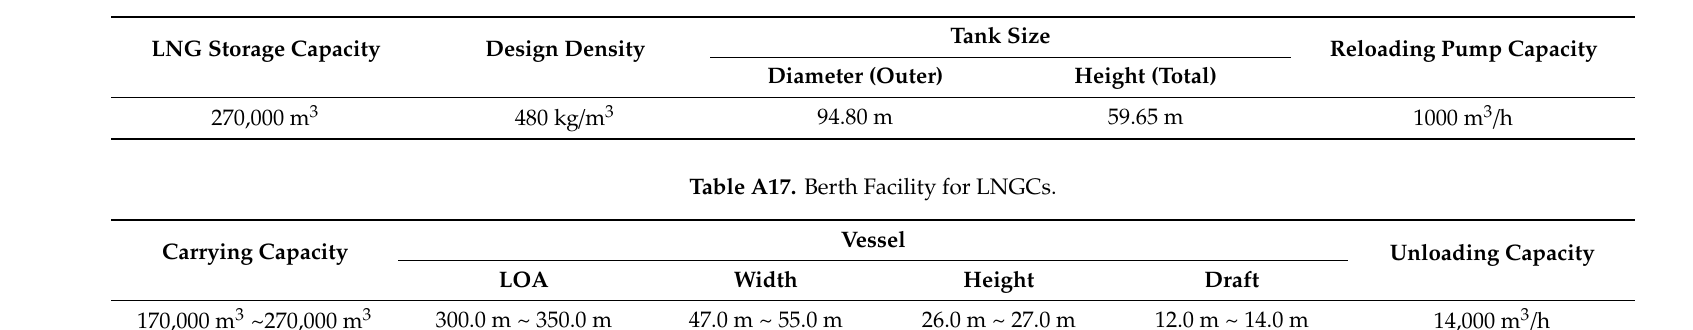
Table A16. LNG Storage Tank.